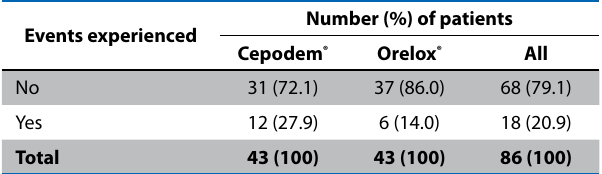
Table IV. Adverse